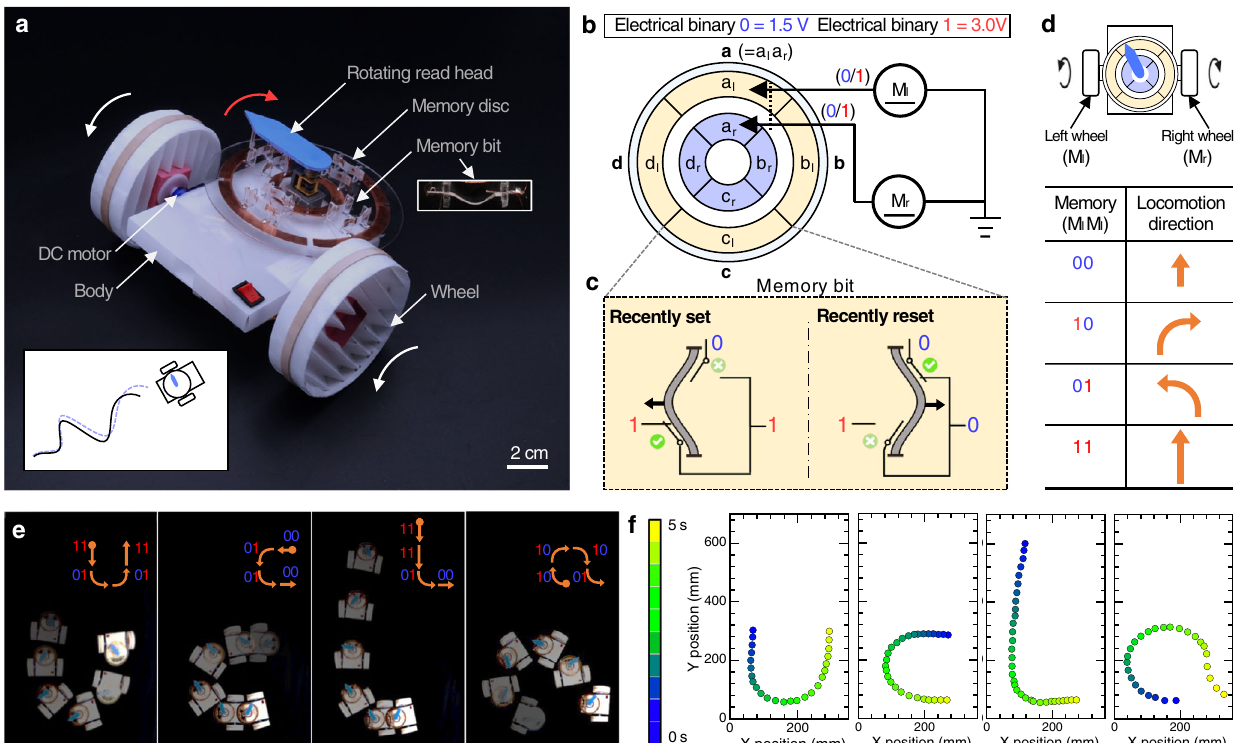
Fig.7|Origamiwheeledcar.a Thedetailedstructureoftheorigamicarwithlabels. The rotating read head extracts the stored memory (voltage) from the disc and forwardsthattotwoDCmotorstocontrolthelocomotiondirectionofthecar. b The simpli fi edcircuitdiagramofthewheeledcar.Eachcompositememorybitconsistsof two basic memory bits, which control the corresponding wheels through two DC motors. For example, composite memory bit, a, is composed of two basic memory